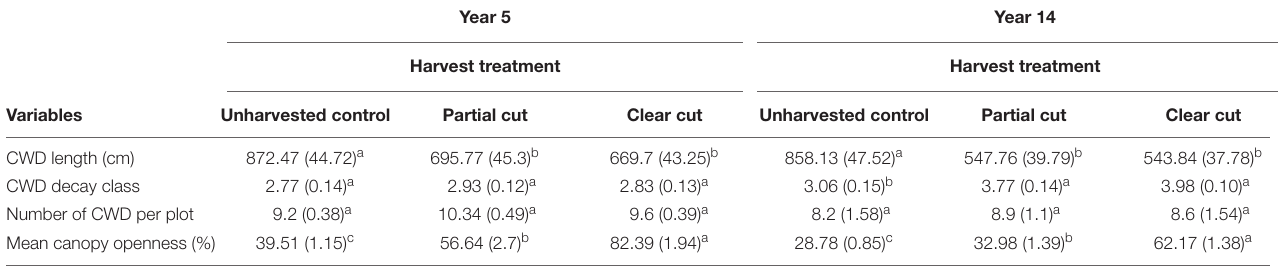
TABLE 1 | Mean ( ± SE) values of coarse woody debris (CWD) characteristics and canopy openness for each treatment between years 5 and